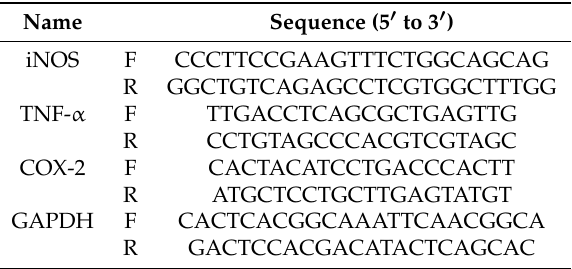
Table 1. Primer sequences used in the RT-PCR